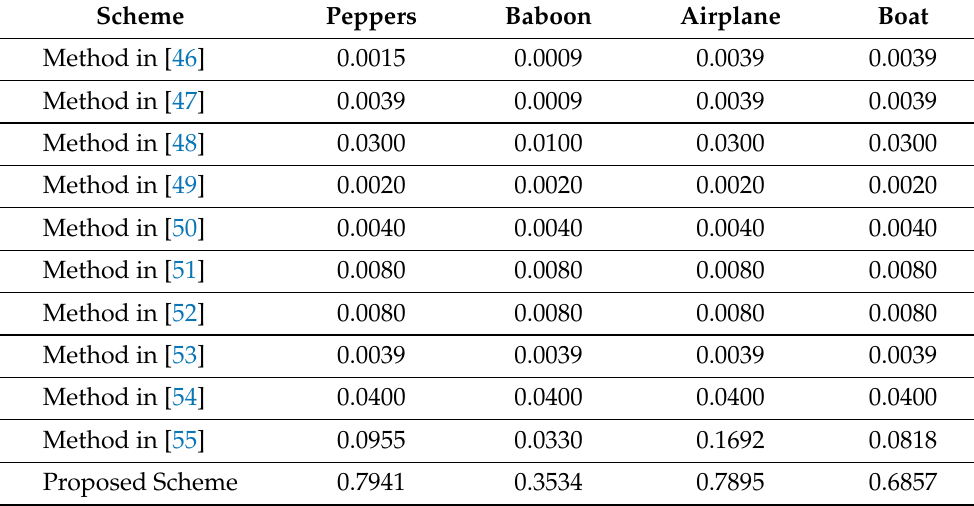
Table 4. Comparison of embedding rate for the well-known images.